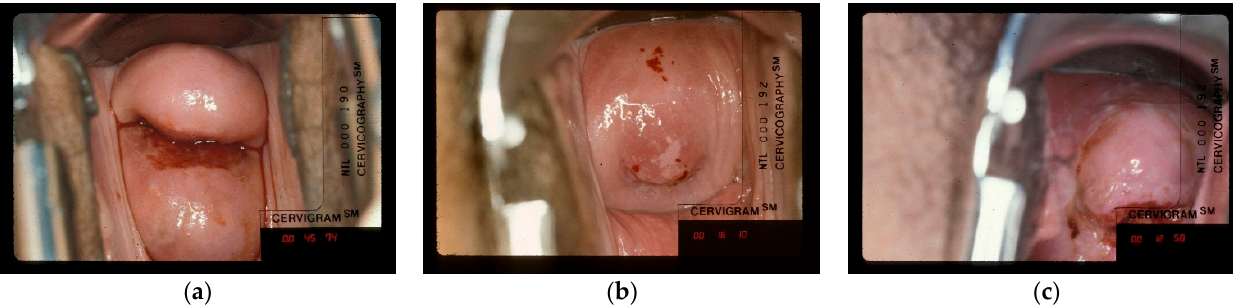
Figure 7. ( a ) Image sample labeled as “treatable” but considered as “not treatable” by the human expert. ( b , c ) Image samples that the human expert considers as “bad image” (the full cervix is not visible and bad focus).